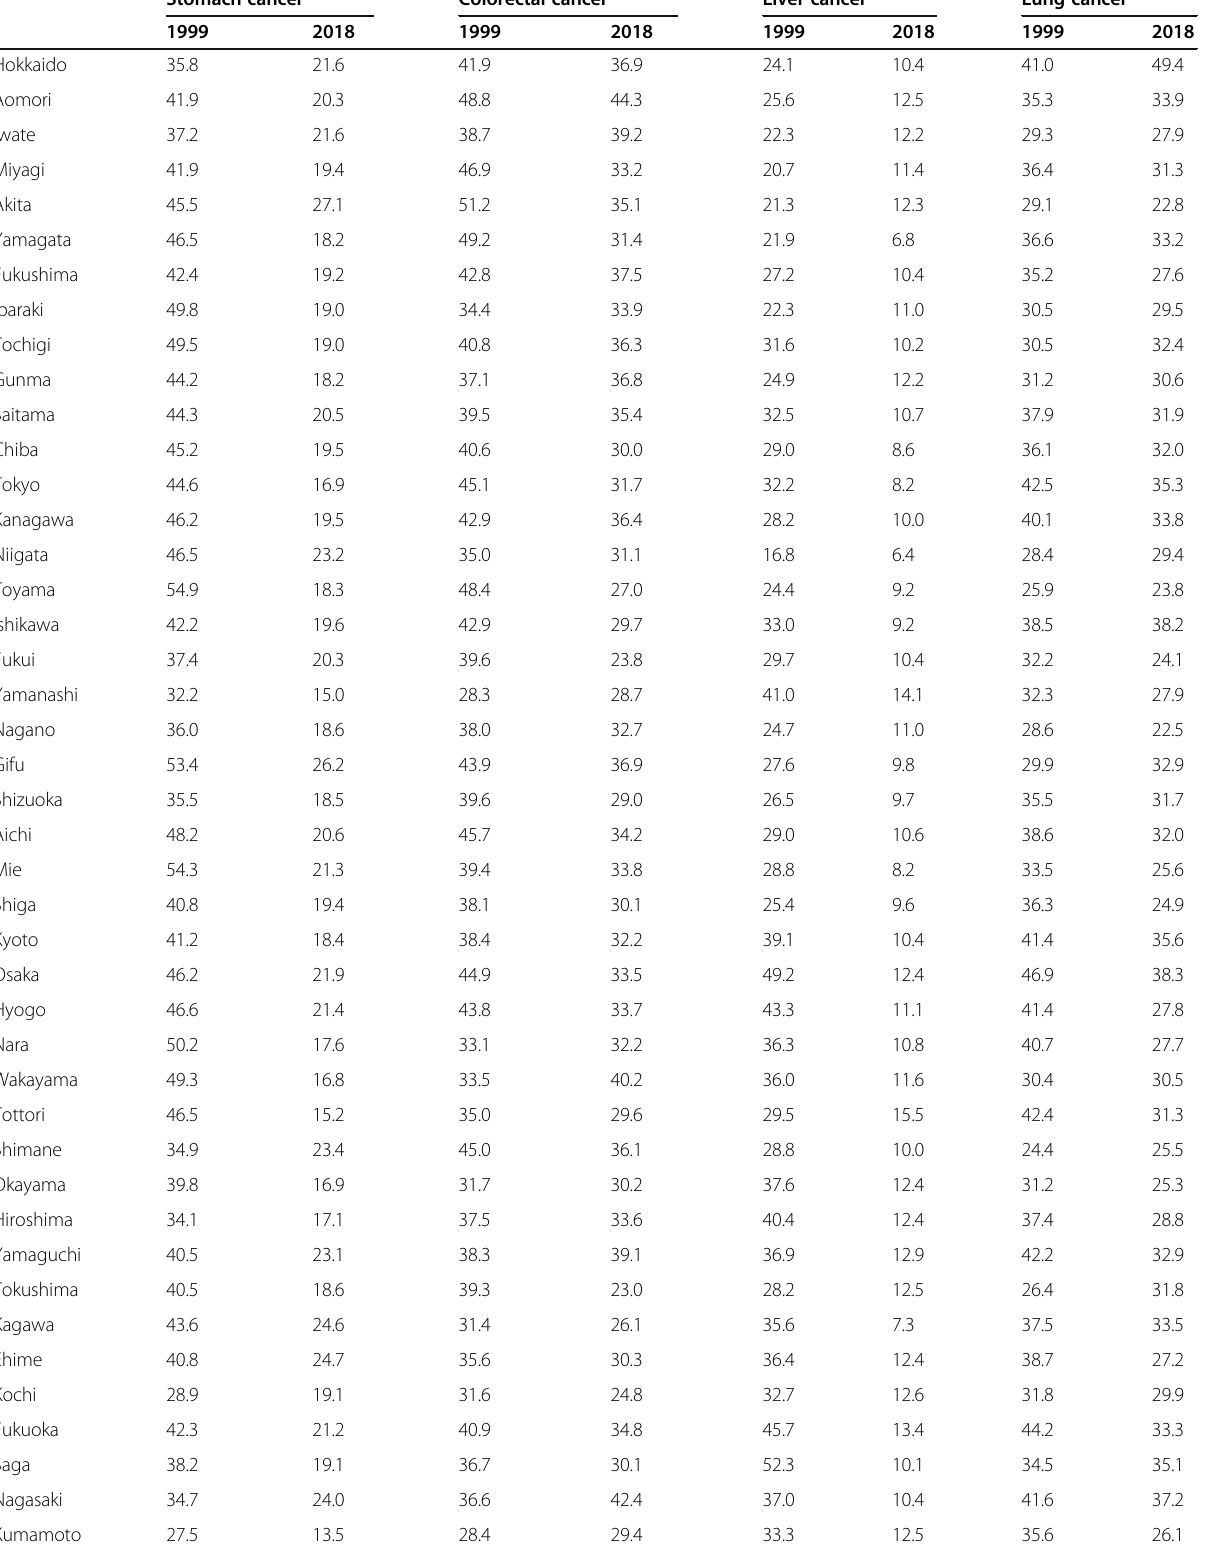
Table 2 Age-standardized mortality rates for each type of cancer in 1999 and 2018 among